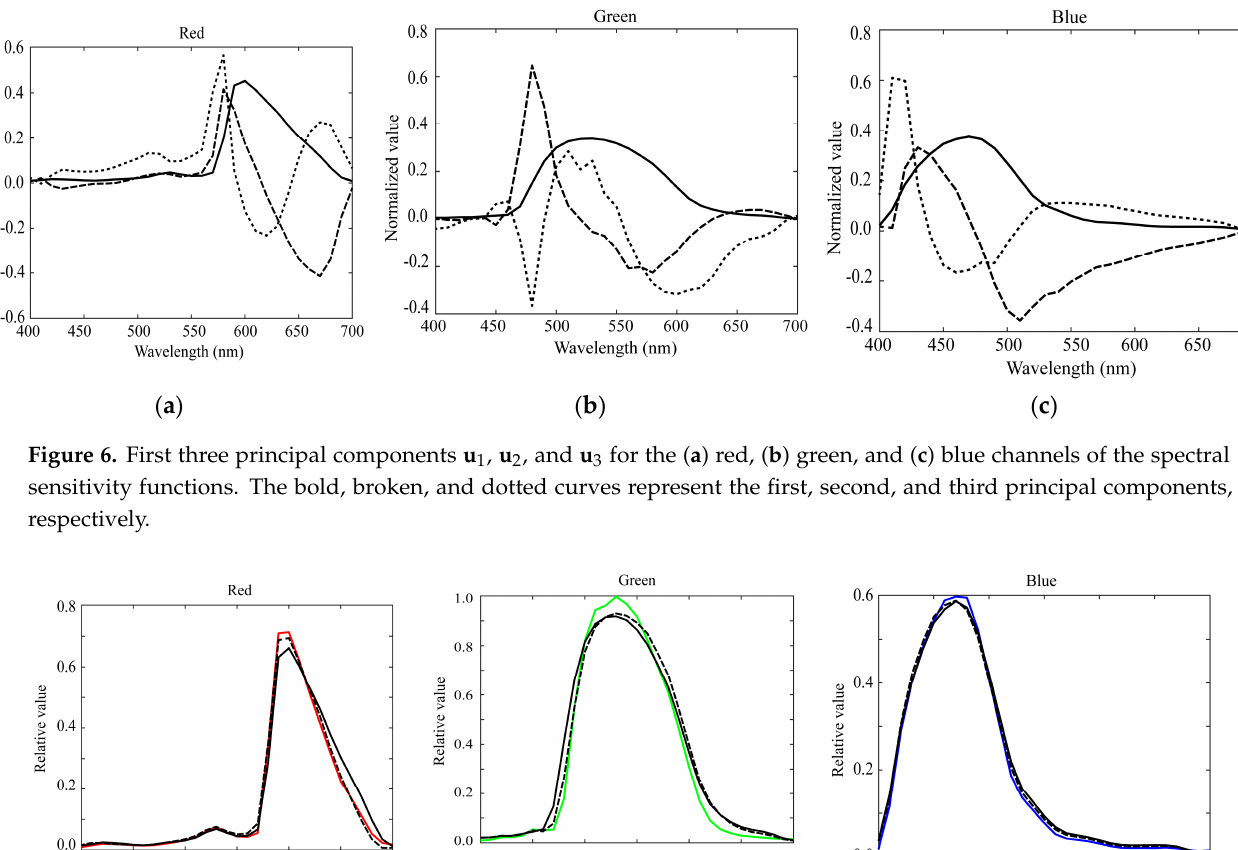
Figure 7. Approximated spectral curves for the ( a ) red, ( b ) green, and ( c ) blue channels of the iPhone 8 spectral sensitivity functions. The colored bold curves, black bold curves, and broken curves represent the measured spectral sensitivities, approximations using the first component only, and approximations using the first two components,